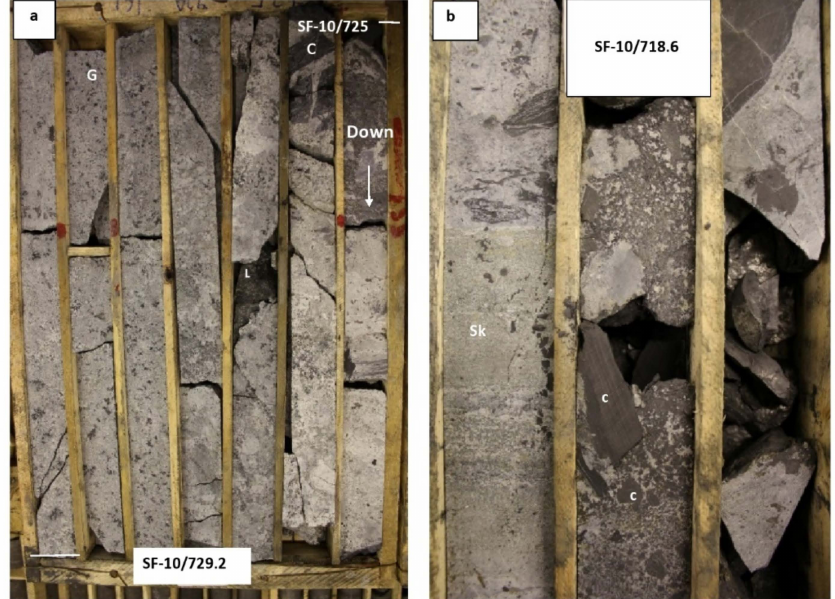
Figure 15. Interaction of gabbro–dolerites with host rocks: coal in the upper zone of the Talnakh intrusion, drillhole SF-10; ( a ) a transitional zone from leucogabbro to contact gabbro–dolerites with coal xenoliths; and ( b ) coal xenoliths in the roof of the intrusion. C, coal; G, gabbro–dolerites; Sk, skarn. The core diameter is 47